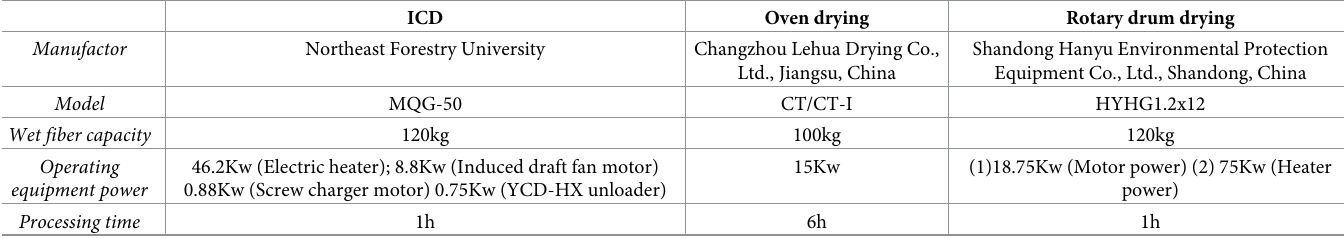
Table 3. Optimum operating parameters of different drying methods.